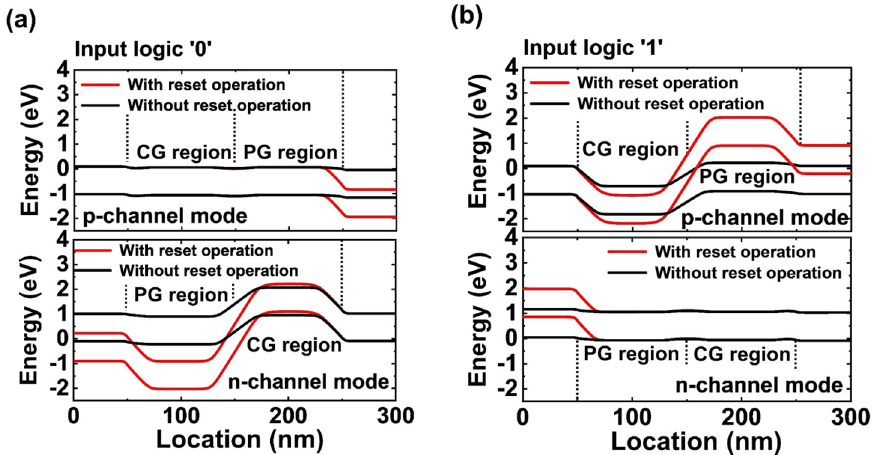
Figure 3. Energy band diagrams of the DG FBFETs in the n- and p-channel modes during the ( a ) input logic ‘0’ and ( b ) input logic ‘1’. The reset operation modulates the height of the potential barrier in the channel region. The data were extracted from the timing diagrams of the ns time step in Fig. 2(b) and